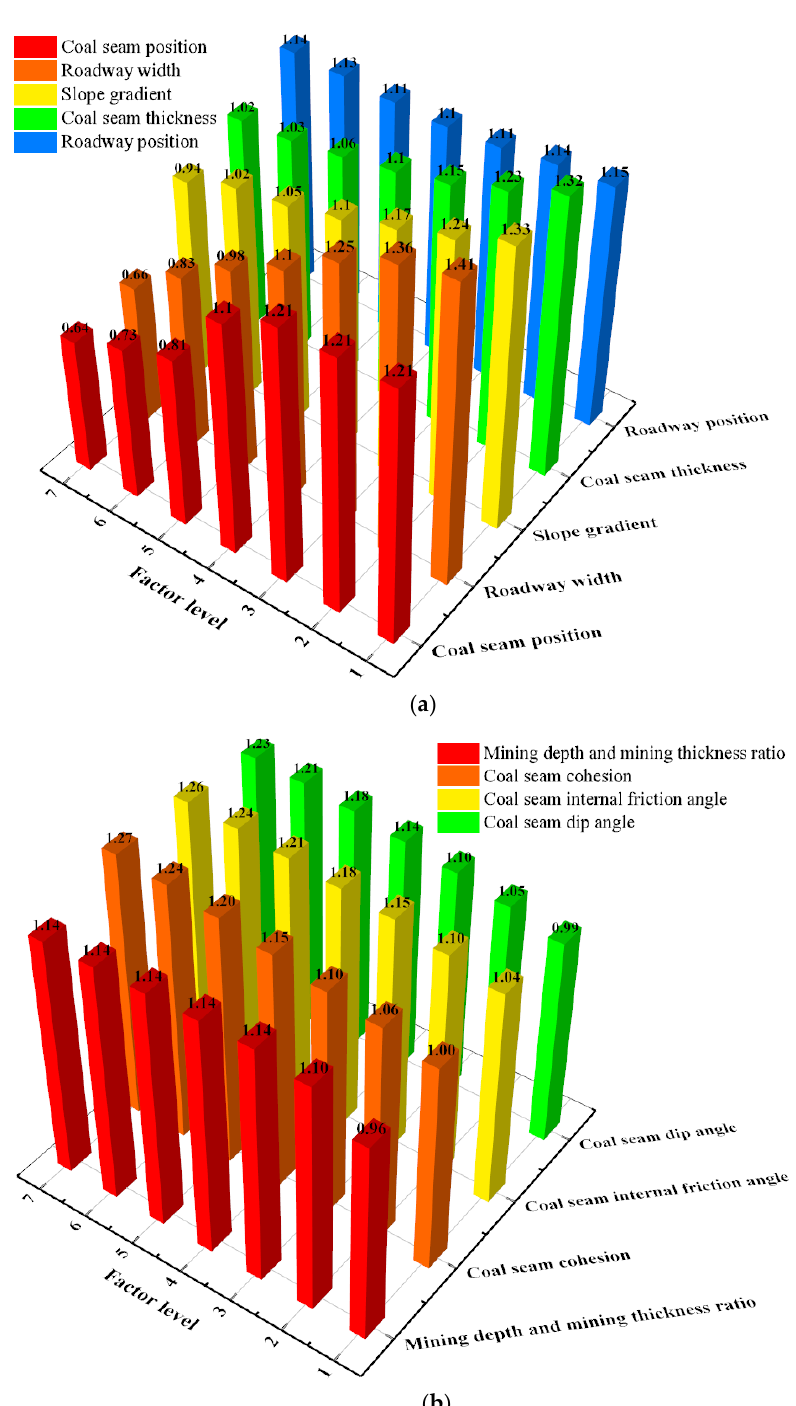
Figure 9. Stability coefficient of a slope containing a coal seam in a goaf under different influencing factors. ( a ) influencing factors: the coal seam position, the roadway width, the slope gradient, the coal seam thickness and the roadway position; ( b ) influencing factors: the mining depth and mining thickness ratio, the coal seam cohesion, the coal seam internal friction angle and the coal seam dip angle.